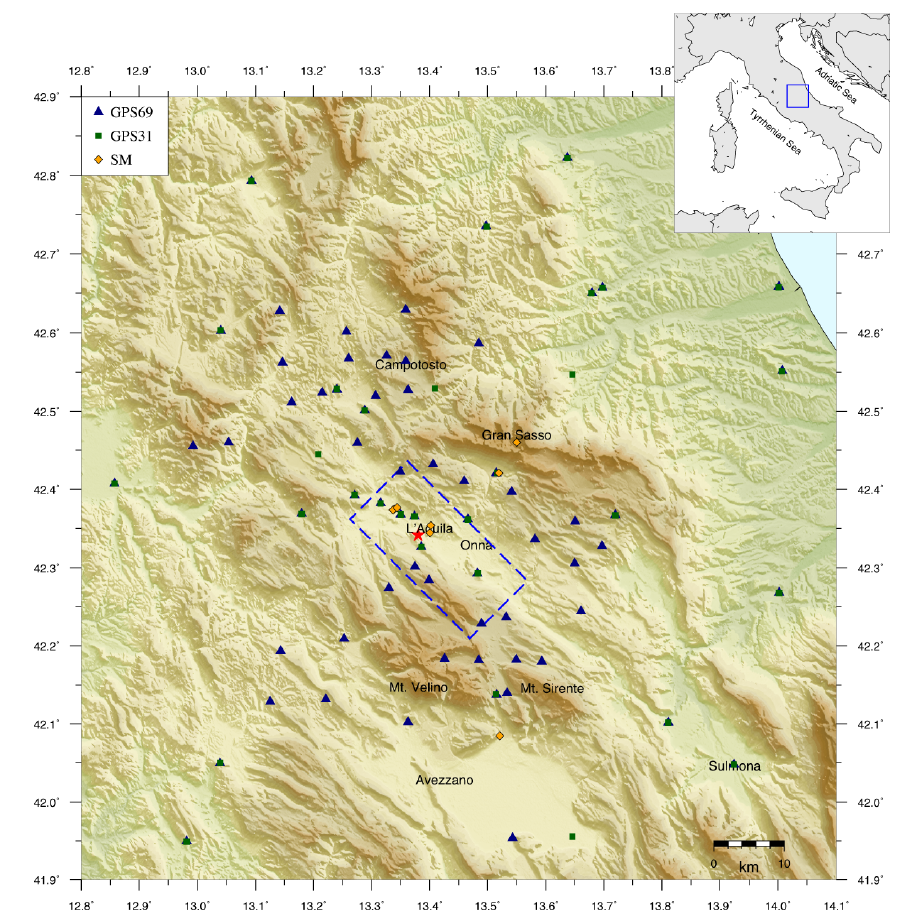
Figure 1. Overview map of the study area with the location of GPS and SM stations used in the present work. The red star indicates the main shock, while the blue dotted box is the surface projection of the fault